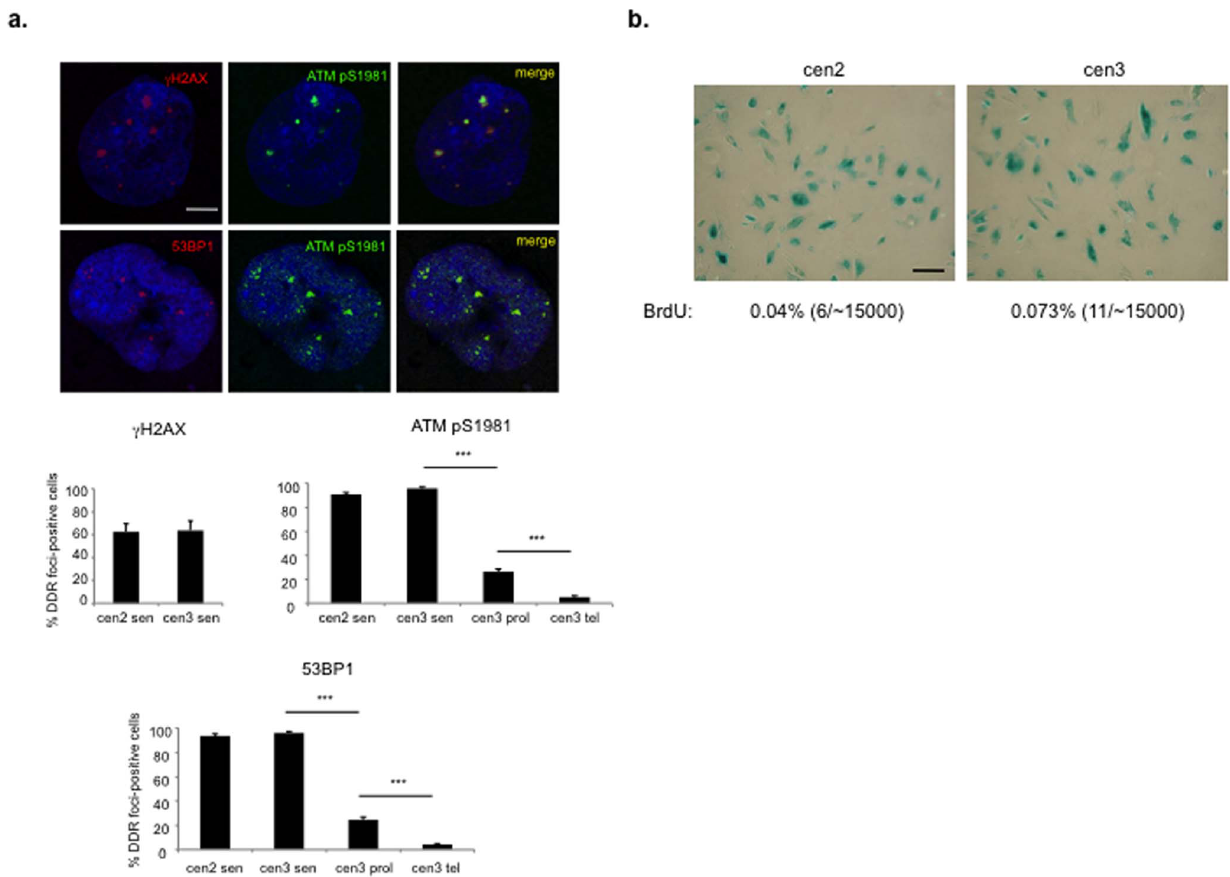
Figure 2. Telomere-initiated senescent cells retain active DDR foci for years after senescence establishment. a. DDR, in the form of ATM pS1981 foci co-localizing with 53BP1 and c H2AX foci, is detectable three years after senescence establishment. Scale bar, 10 m m. Below, bar graphs show the percentage of cells positive 6 s.e.m. for the indicated DDR markers, in senescent (sen), early passage proliferating (prol) or telomerized proliferating (tel) skin fibroblasts from two independent centenarian donors (cen2 and cen3). Cells were considered positive if bearing more than 3 DDR foci (*** p-value , 0.001). b. SA- b -gal staining of the two batches, cen2 and cen3, is shown together with the percentage of BrdU- positive cells. Scale bar, 100 m